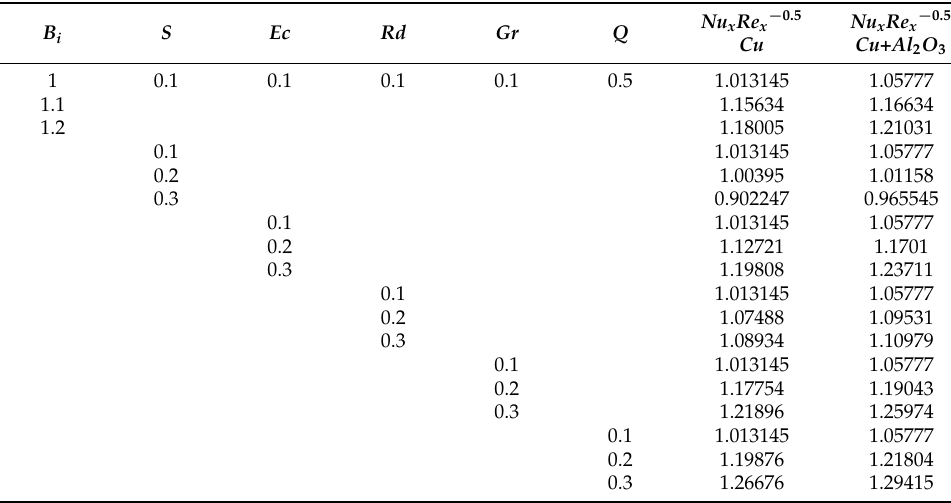
Table 4. The combination of quantitative data versus a set of